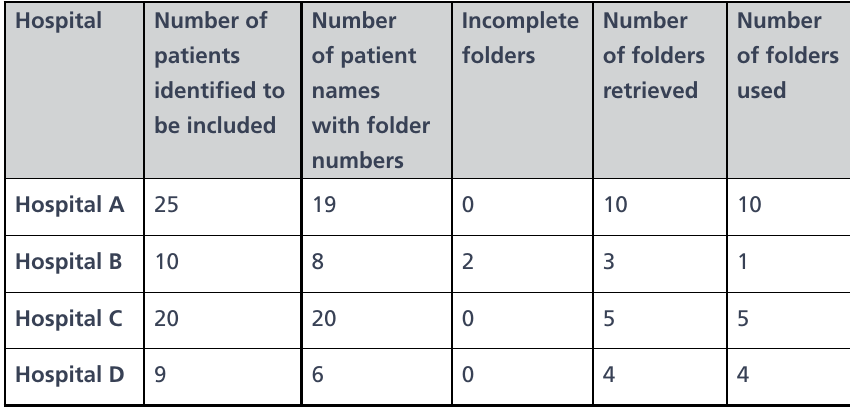
Figure 1: Possible reasons for fol ders being excluded from the archival survey (n=64). table 1: summary of folders obtained at each